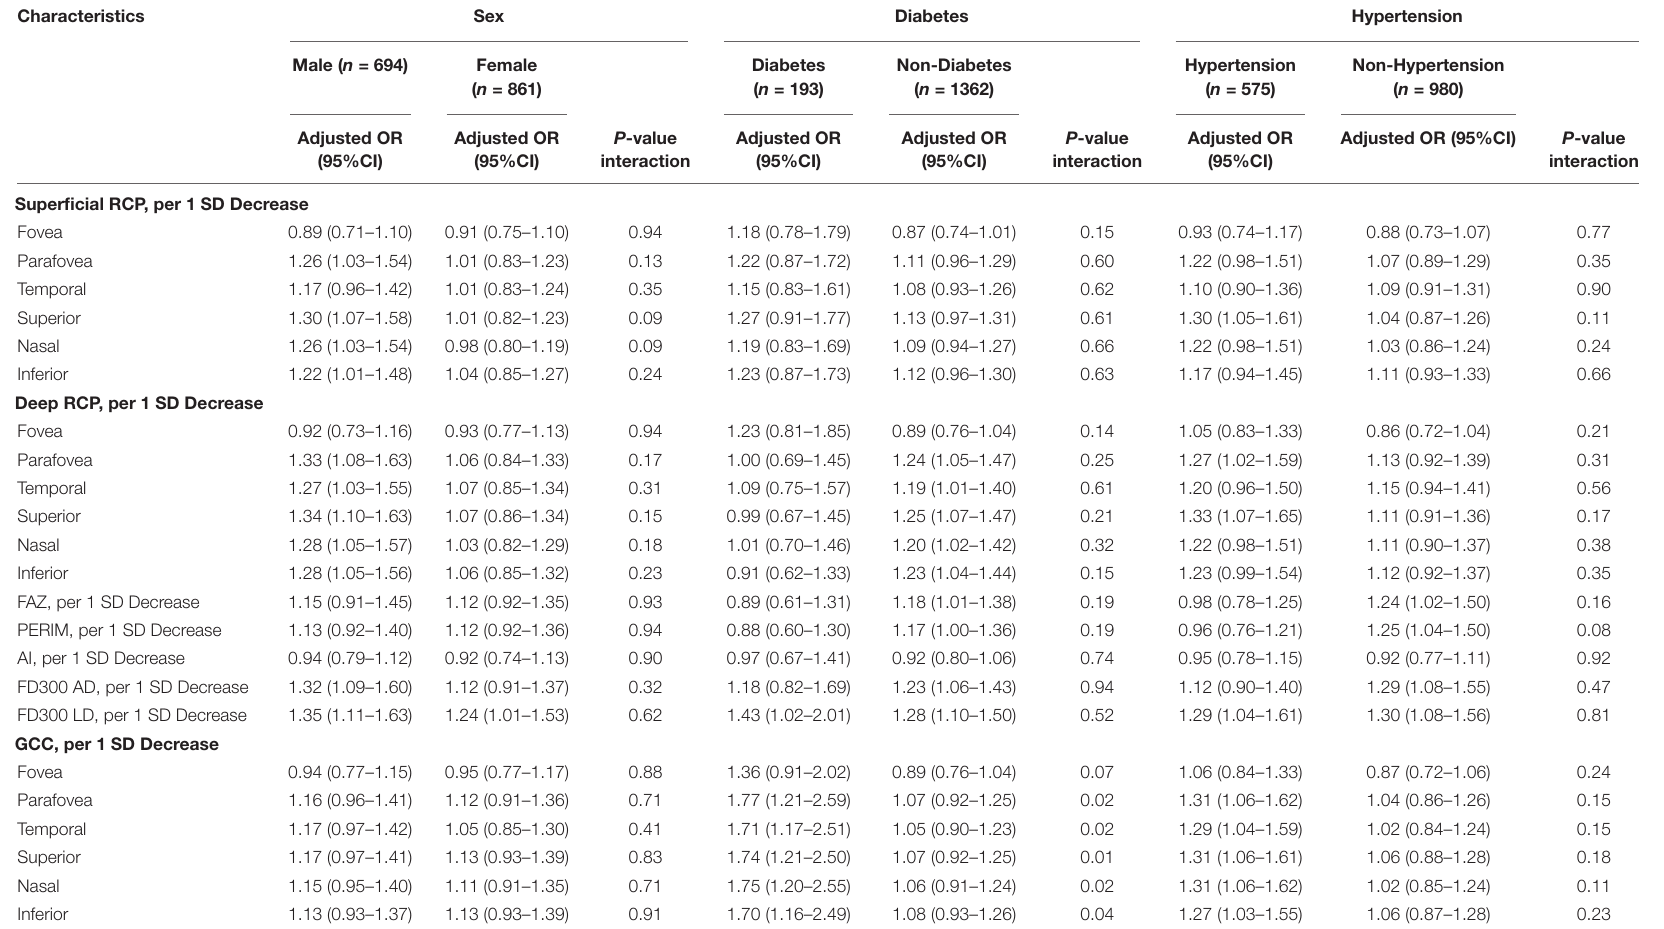
TABLE 4 | Subgroup analyses of association of RCP and GCC with cognitive impairment based on sex, diabetes, and hypertension.